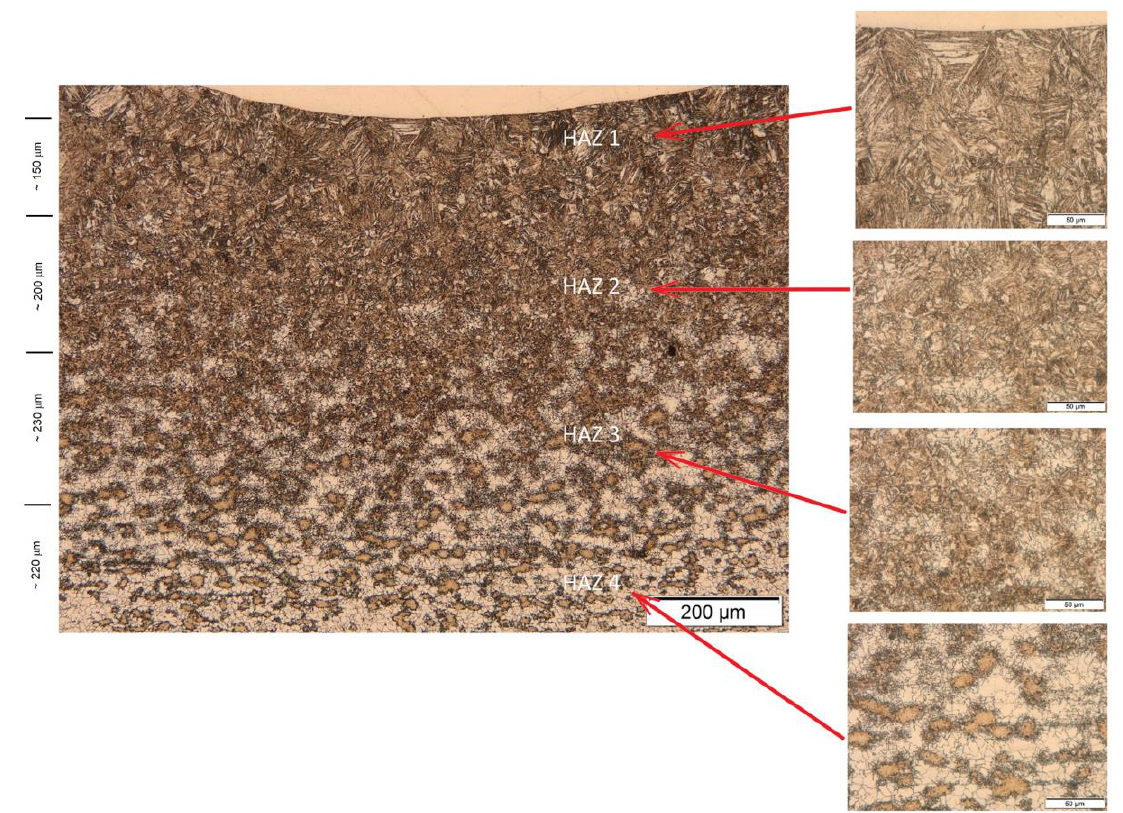
Figure 13. The micrograph showing the interface between the Ni-20Cr+Re coating and the 16Mo3 steel substrate obtained at the 2400 W laser power. Four different microstructure subzones (HAZ 1, HAZ 2, HAZ 3, HAZ 4) can be distinguished within the heat-affected zone.